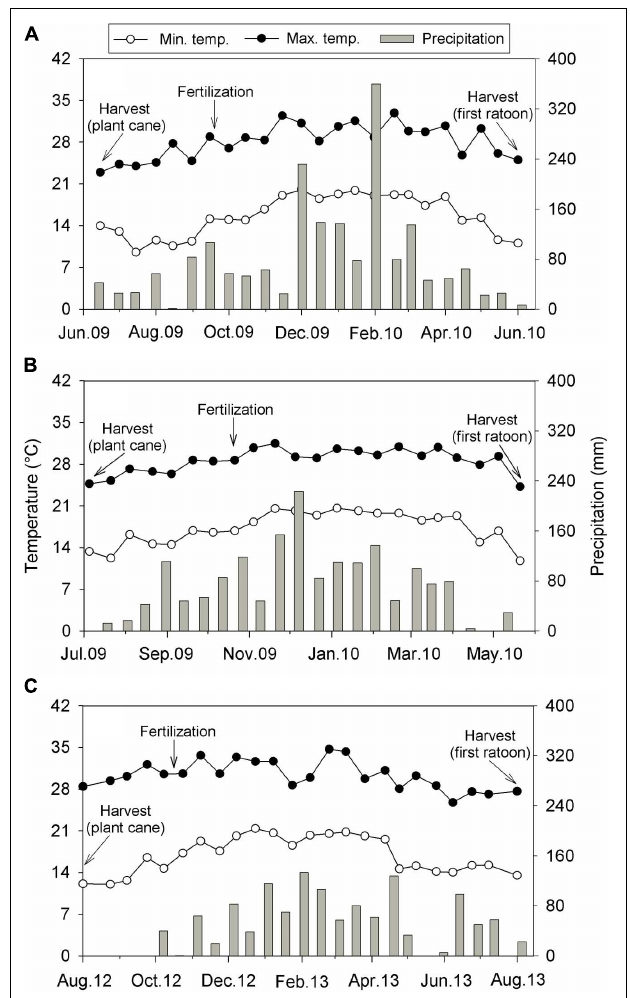
FIGURE 1 | Biweekly precipitation and mean biweekly minimum and maximum air temperatures during a sugarcane growing season (first ratoon cycle) conducted at Site 1 (A), Site 2 (B), and Site 3 (C), all located in the Southeast region of